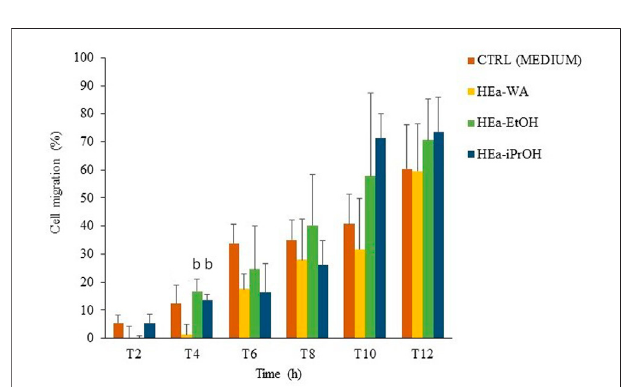
Frontiers in Pharmacology |